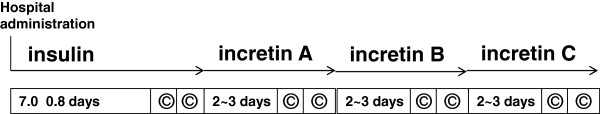
Study protocol. Incretin A-C indicates 0.3 mg liraglutide, 50 mg vildagliptin, or 6.25 mg alogliptin. ©: CGM monitoring day.